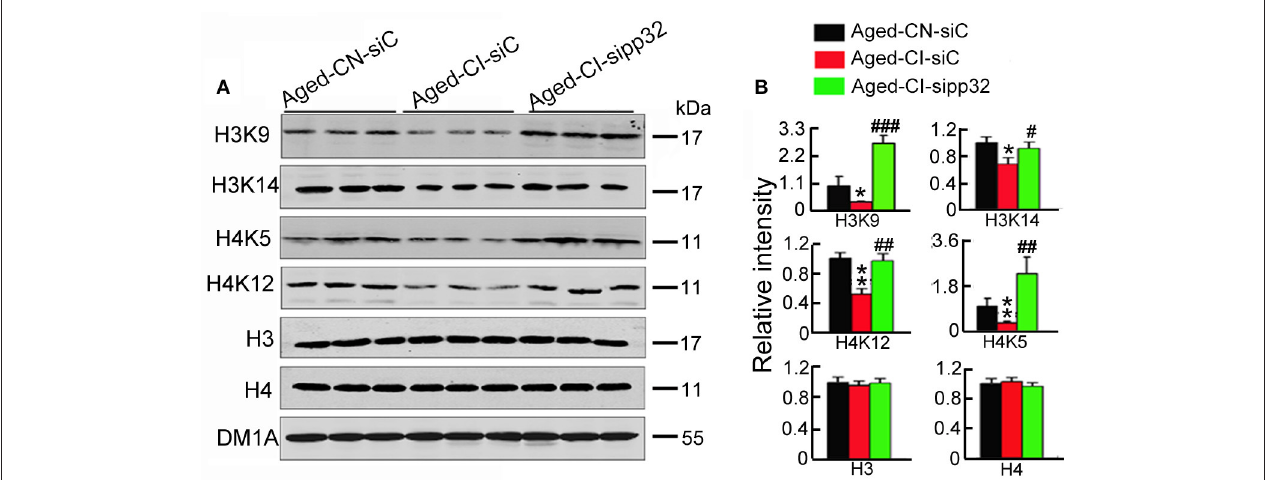
FIGURE 5 | Sipp32 increases the level of acetylated histone. (A,B) Western blotting (A) and quantitative analysis (B) of the level of acetylated histone in the hippocampal CA3 region of Aged-CN-siC, Aged-CI-siC and Aged-CI-sipp32 animals ( n = 3 for each group). * p < 0.05, ** p < 0.01 vs. Aged-CN-siC; # p < 0.05;